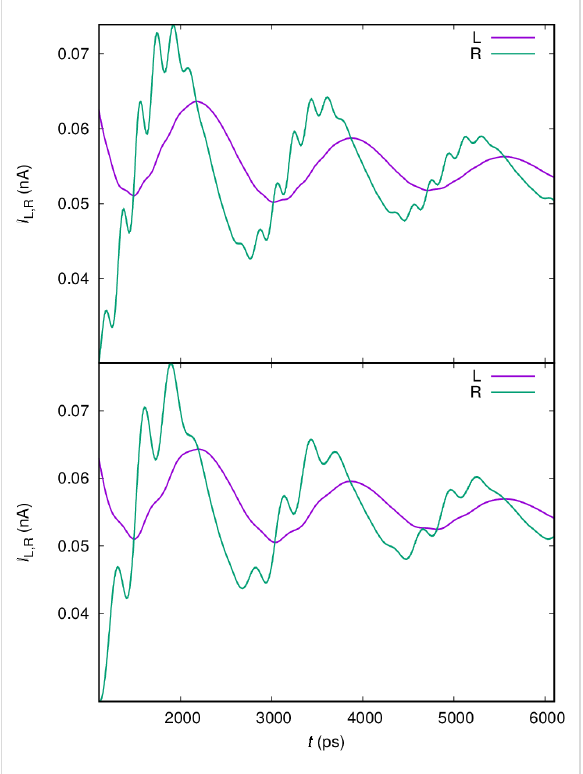
Figure 6: The current from the left lead (L) into the central system and the current from the central system into the right lead (R), for x - (upper), and y -polarized (lower) cavity photon field. g EM = 0.10 meV, = 0.343 meV, κ = 1.0 × 10 − 5 meV, = 0, and B ext = 0.1 T.